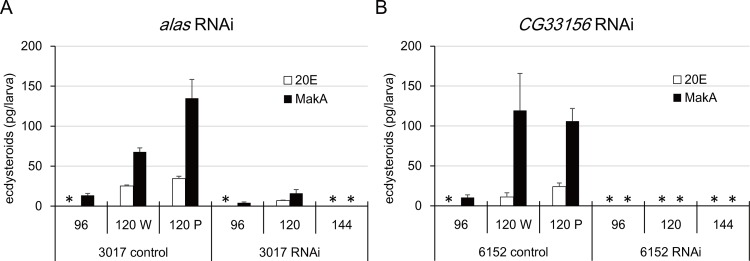
Ecdysteroids in D. melanogaster RNAi larvae.Whole body 20E and MakA titers of RNAi and control larvae were measured by LC-MS/MS. (A) 20E and MakA titers of alas RNAi animals. (B) 20E and MakA titers of CG33156 RNAi animals. Data are from three or four biological replicates, which consisted of 10 larvae or 5 pupae for each data point. W: wandering larvae and P: prepupae. Values are mean ± S.E.M. and asterisks indicate under quantitation limit (2.5 pg/larva or 5 pg/pupa).